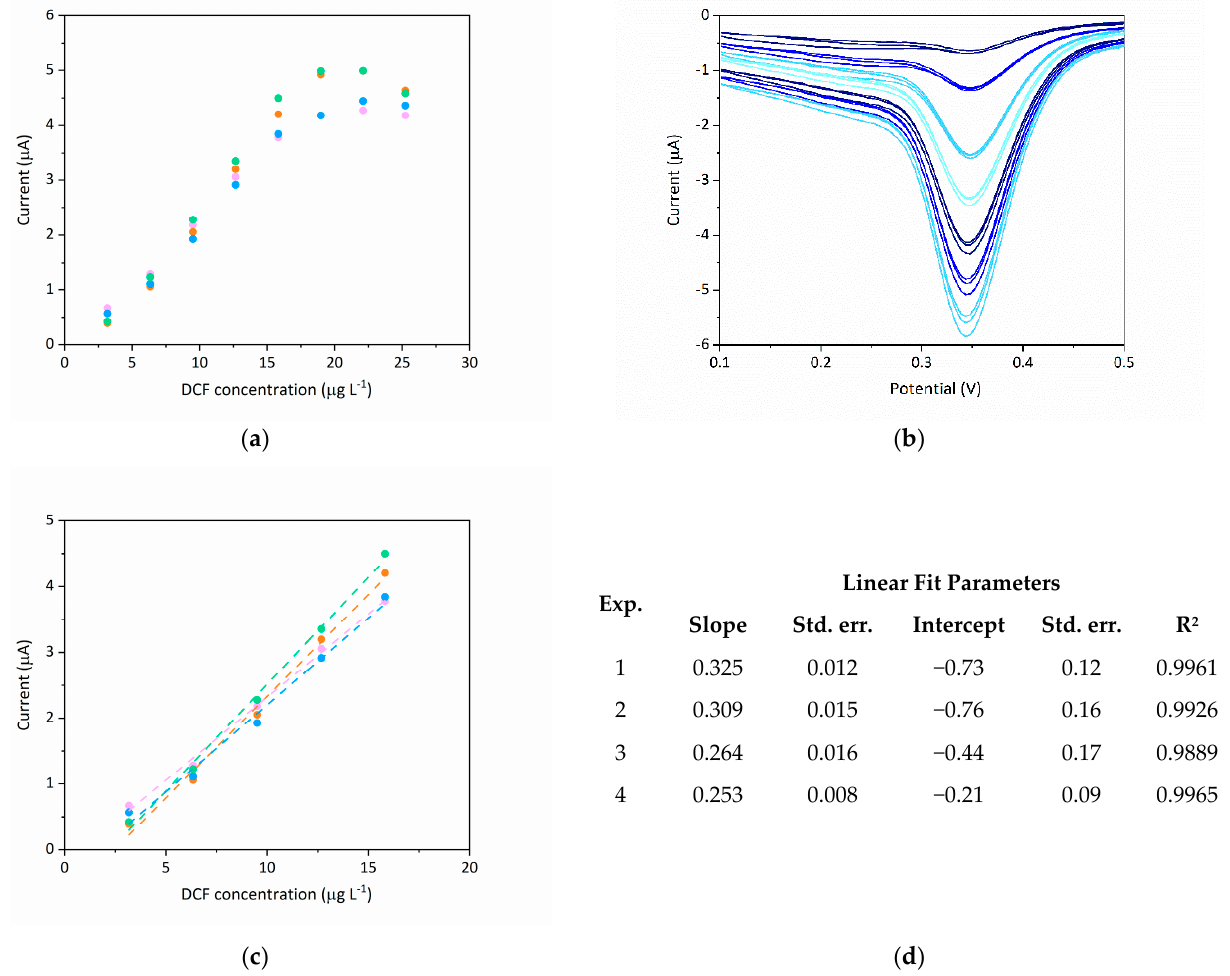
Figure 7. ( a ) Reduction peaks obtained by DPV on the DCF by-product adsorbed on the aGCE sur- face (3-22 µg L − 1 DCF; PB 5 × 10 − 2 mol L − 1 pH 2.0; E vs. Ag/AgCl; three replicates for each concentration